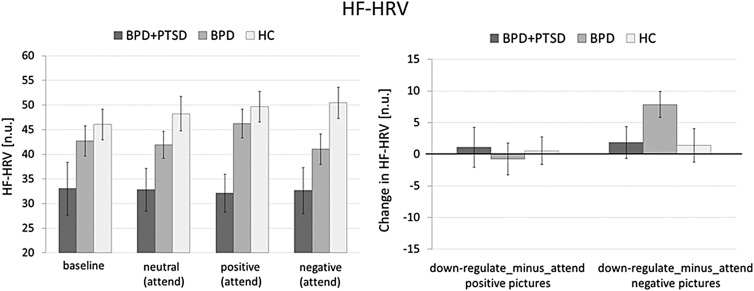
Means and standard errors of the mean of HF-HRV (normalized units) in patients with BPD + PTSD, BPD patients without comorbid PTSD (BPD), and HC during baseline conditions and the ER task. The left graph shows HF-HRV during baseline and the passive viewing conditions of the ER task (baseline, negative_attend, positive_attend, neutral_attend, and emotional reactivity). The right graph depicts changes in HF-HRV for the ‘down-regulate’ minus ‘attend’ condition (regulate_minus_attend_negative, regulate_minus_attend_positive, and ER).